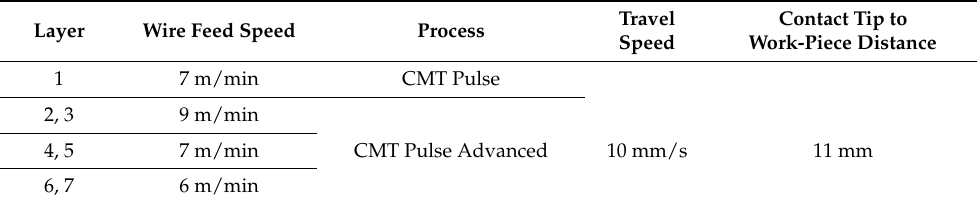
Table 2. Deposition